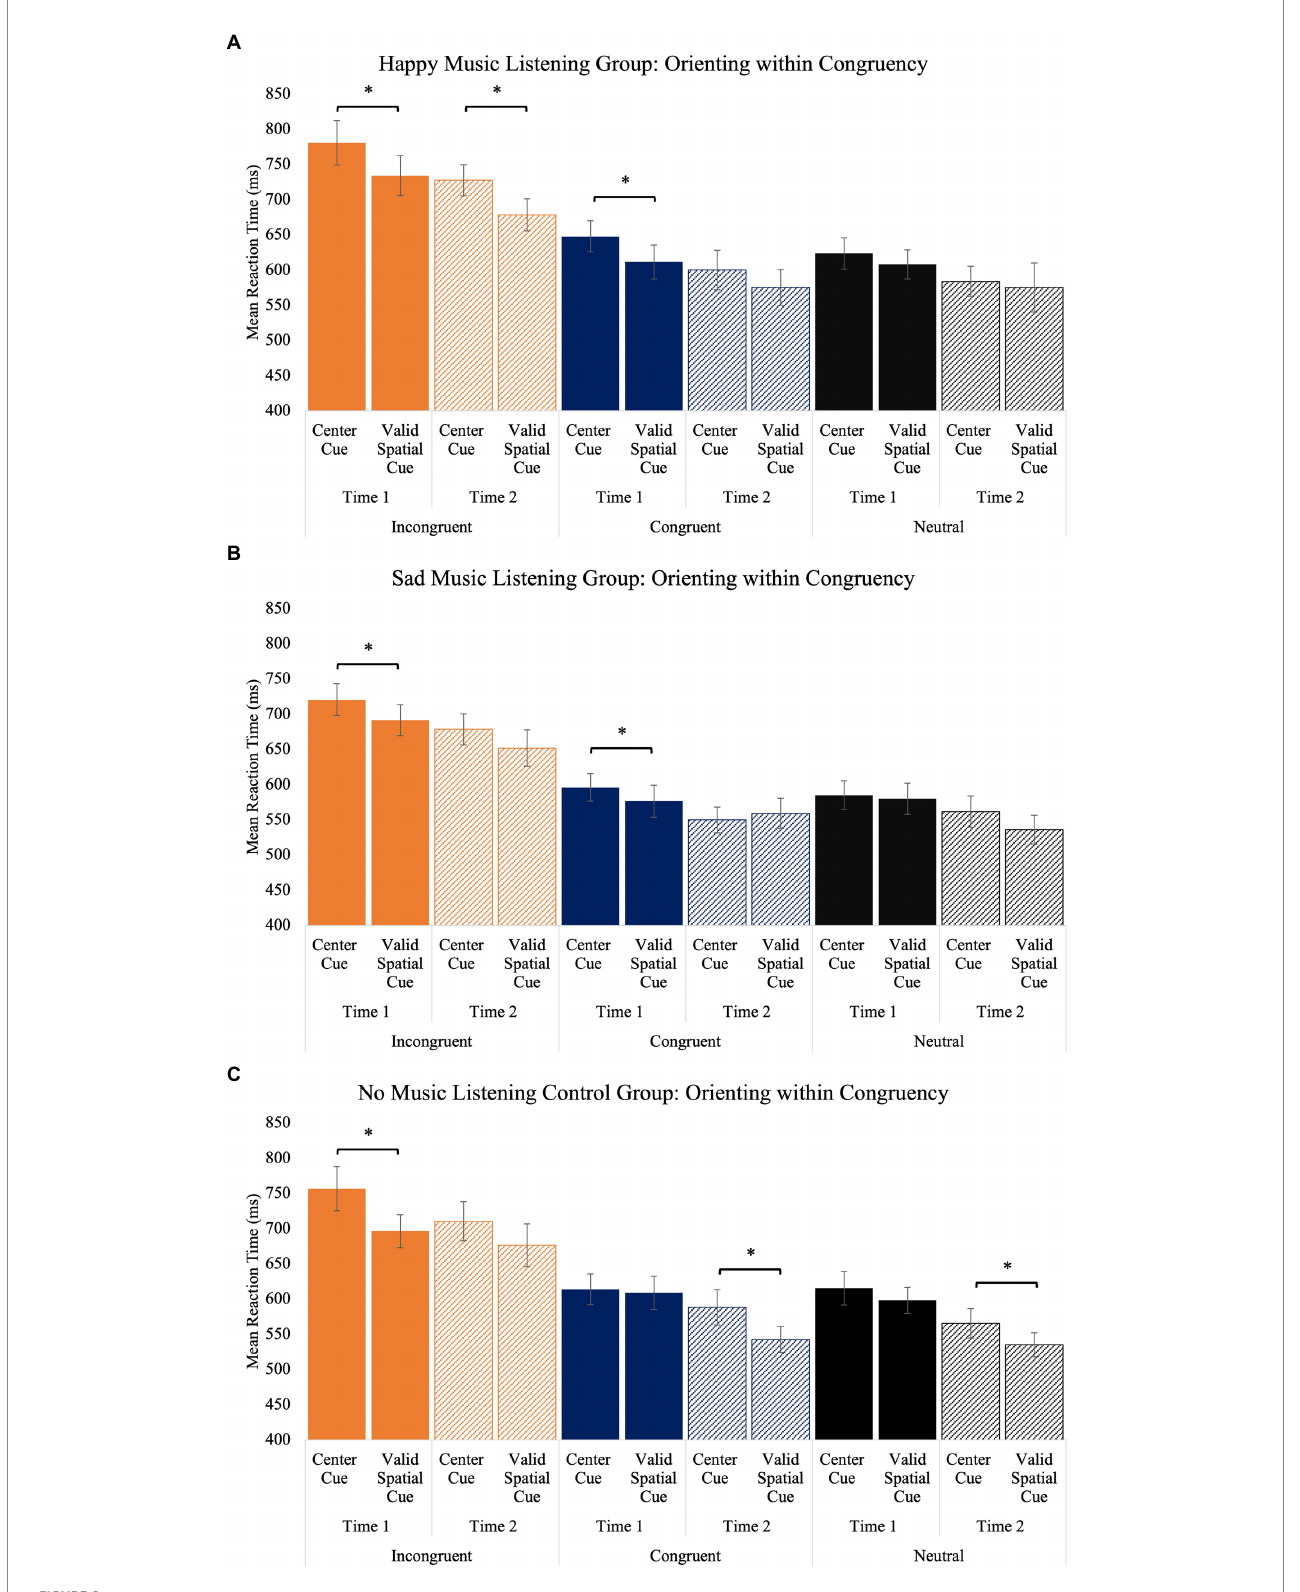
FIGURE 6 The orienting (center cue vs. valid spatial cue) effect separated by congruency (incongruent, congruent, and neutral) for the happy (A) , sad (B) , and no music (C) listening groups. Error bars represent ± 1 standard